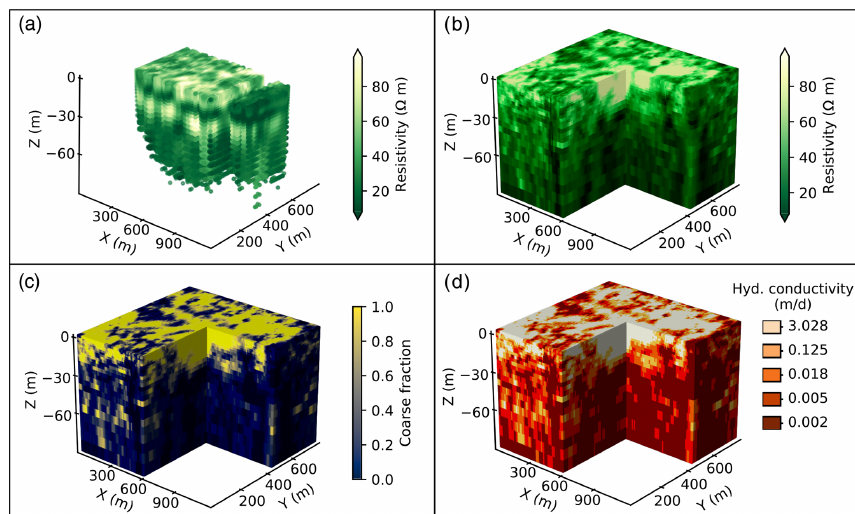
Figure 3. One example realization at each step of the workflow for parameterizing a hydrologic model with tTEM data. Inversion of the tTEM soundings produces a resistivity model of irregularly spaced points (a) . The geostatistical workflow (Sect. 3.2.2) then interpolates and extrapolates the resistivity model onto a rectilinear grid (b) . A rock physics transform is then applied to create realizations of coarse fraction (c) . Finally, after clustering each coarse-fraction realization into distinct facies, each facies is assigned specific parameter values, such as horizontal saturated hydraulic conductivity (d) . All plots are shown with 10 × vertical